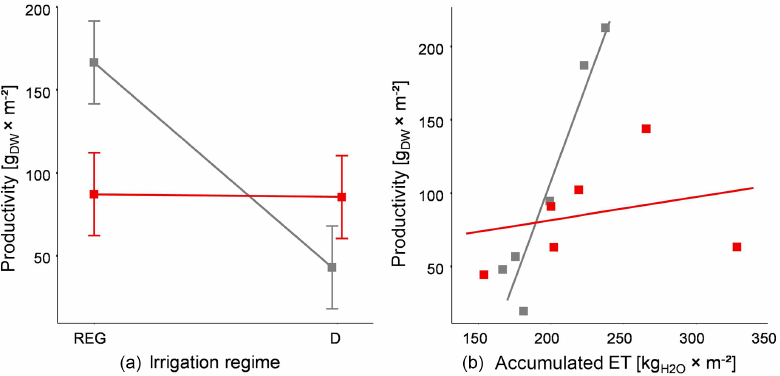
Figure 7. (a) Productivity of two vegetation types ( ± standard error; Stubai – red; Matsch/Mazia – gray; Table 1) subjected to contrasting irrigation schemes (Fig. 1); (b) – dry matter productivity of two vegetation types (see above) as function of accumulated evapotranspiration over the experimental